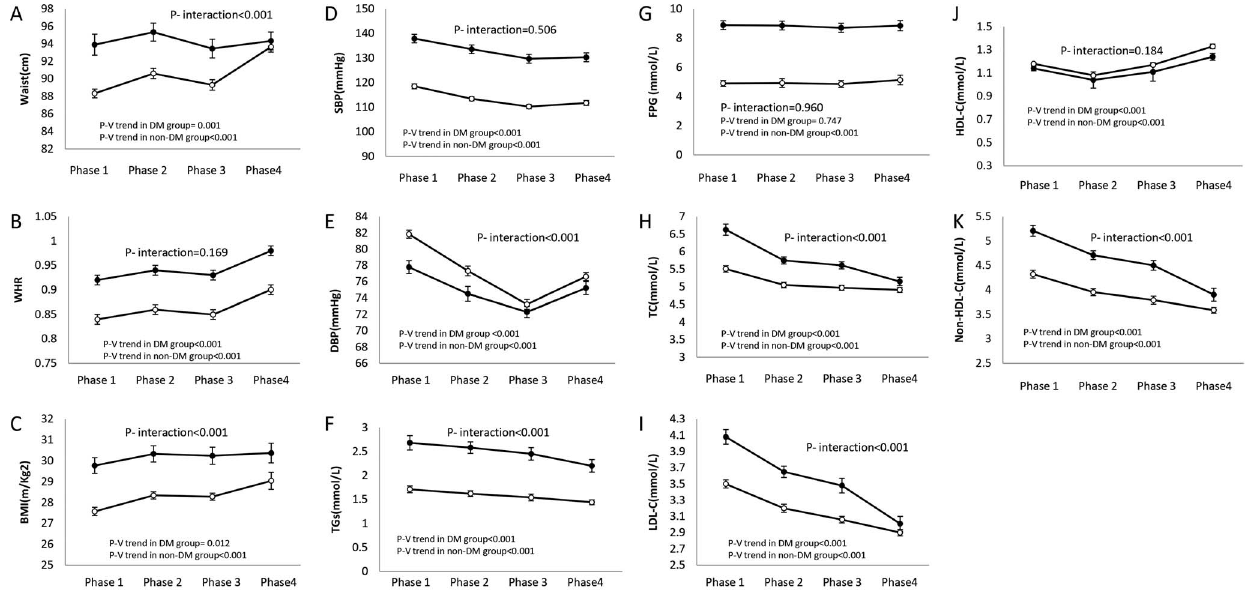
Figure 3. Age-adjusted mean levels of cardiovascular risk factors in each phase in female subjects. Mean levels of cardiovascular risk factors of diabetic and non-diabetic participants was calculated separately with adjustment of related participants’ age in each phase while the interaction of diabetes status was assessed in a pooled model consisting both diabetic and non-diabetic participants. Black circles 5 diabetic group; white circles 5 non diabetic group; DM, diabetes mellitus; WHR, waist to hip ratio; BMI, body mass index; SBP, systolic blood pressure; DBP, diastolic blood pressure; TGs, triglycerides; FPG, fasting plasma glucose; TC, total cholesterol; LDL, low-density lipoprotein cholesterol; HDL-C, high-density lipoprotein cholesterol; Non-HDL-C, non- high-density lipoprotein